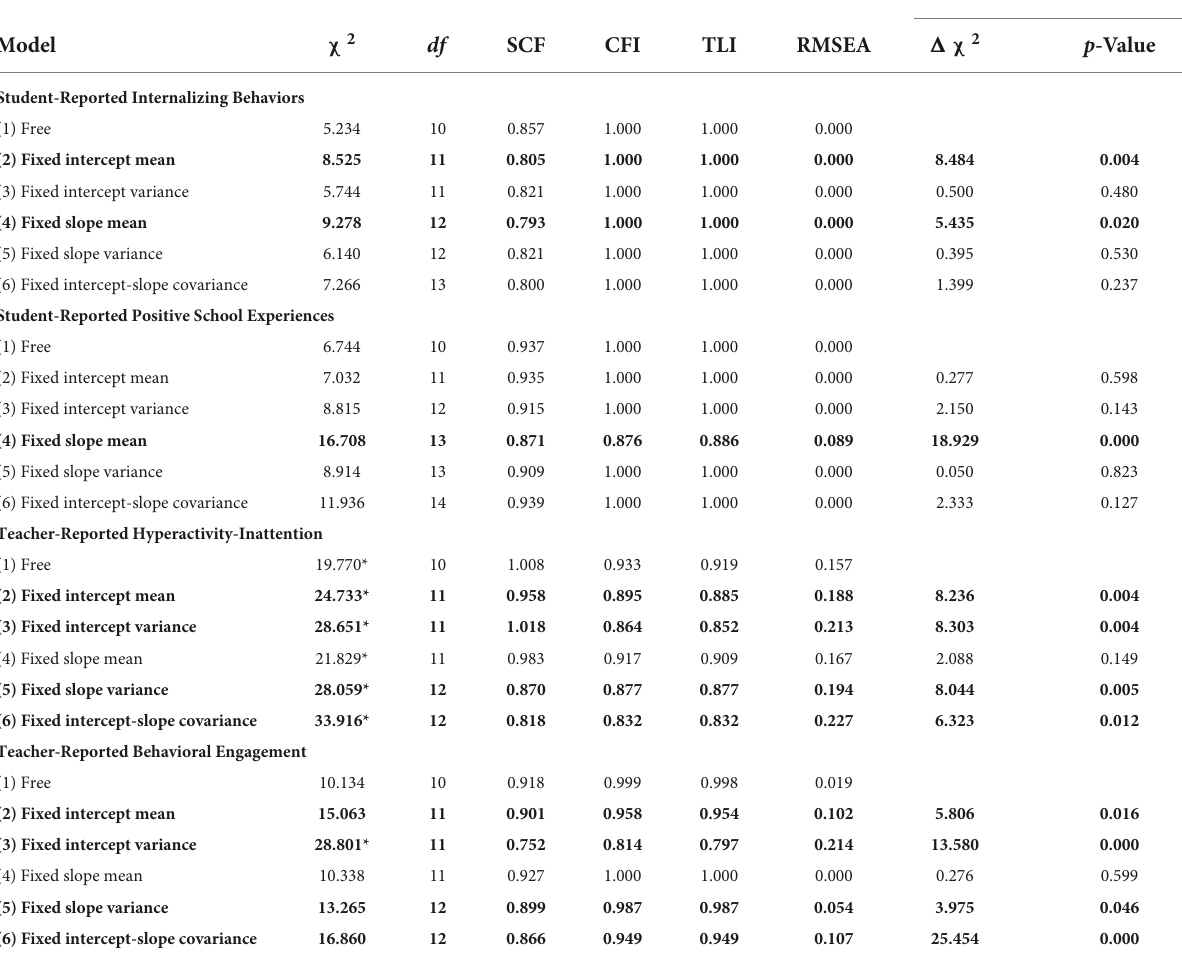
Satorra-Bentler diff.